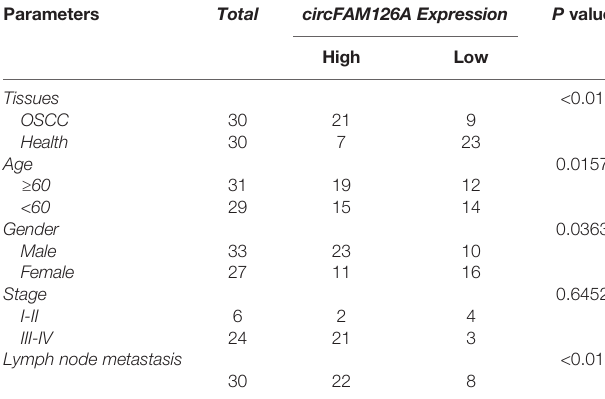
TABLE 1 | Clinical features of OSCC patients.